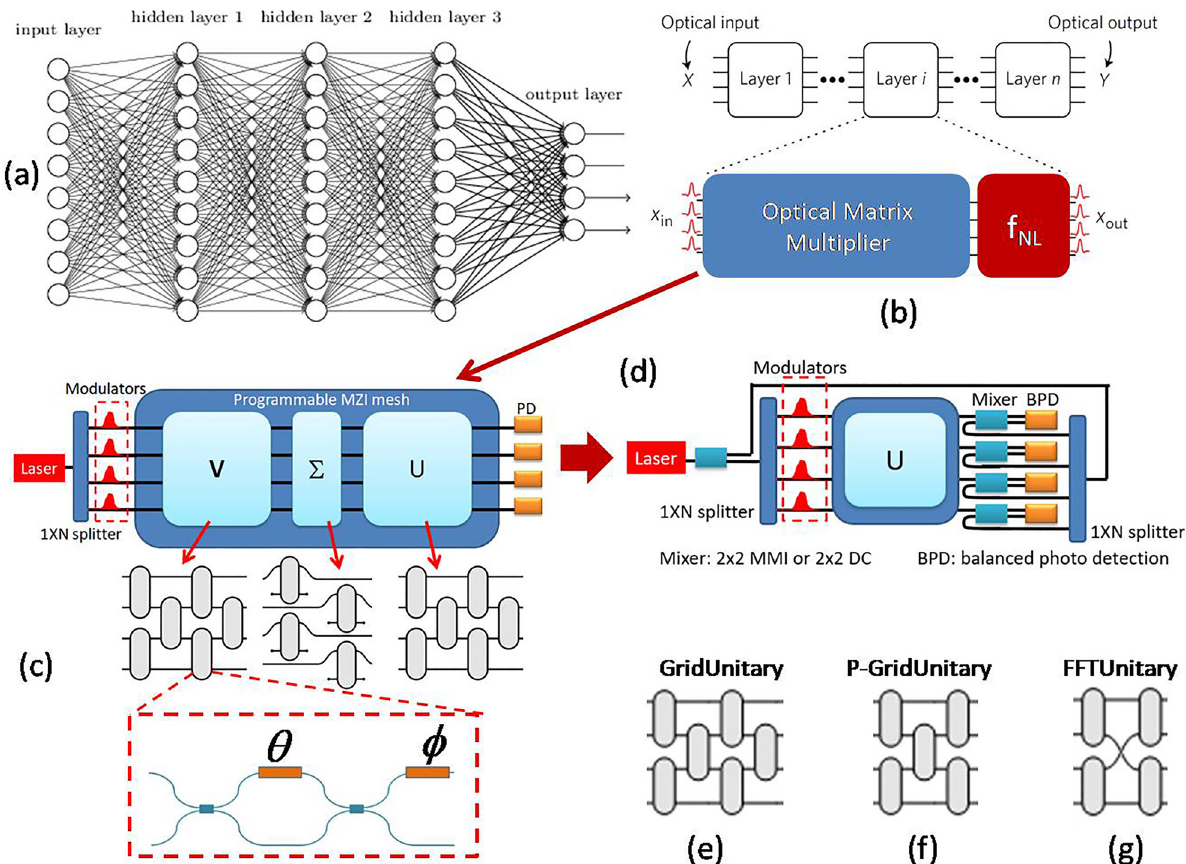
Figure 1: The schematic illustrition of the SVD mesh and pseudo-real-value mesh for matrix-multiplier in PNN. (a)Generalartificialneuralnetworkarchitecturecomposedofaninputlayer,anumberofhiddenlayersandanoutputlayer.(b)Decomposition of the general neural network into individual layers implemented by the optical matrix multiplier and nonlinearity units that compose each layer of the artificial neuralnetwork. Most operationsare the performed onthe optical matrixmultiplier,which conventionally can berealized by(c) SVD-meshcontaining N 2 2 × 2MZIs.(d) Schematicillustrationof thepseudo-real-valuematrixunitaryMZI meshfor matrixexpression;a schematic of (e) universal GridUnitary mesh, (f) nonuniversal P-GridUnitary mesh, and (g) nonuniversal FFTUnitary mesh. (Meaning of the abbreviation in fi gure, PD: photo diode; MMI: multimode interference; DC: directional